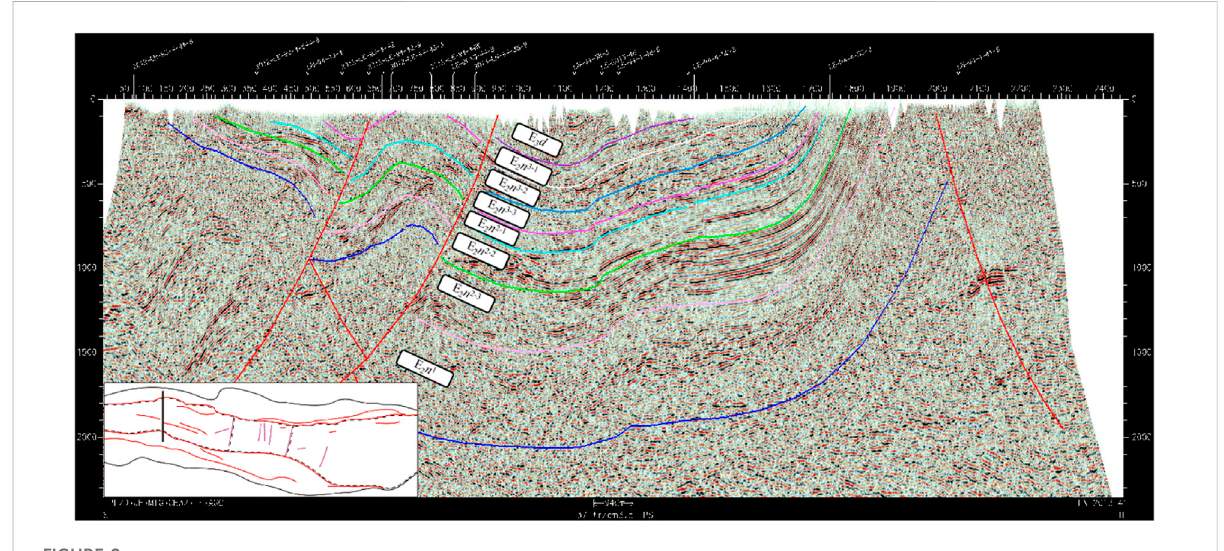
FIGURE 8 Seismic interpretation along line LN 2013 – 41 in NS direction in the western Lunpola